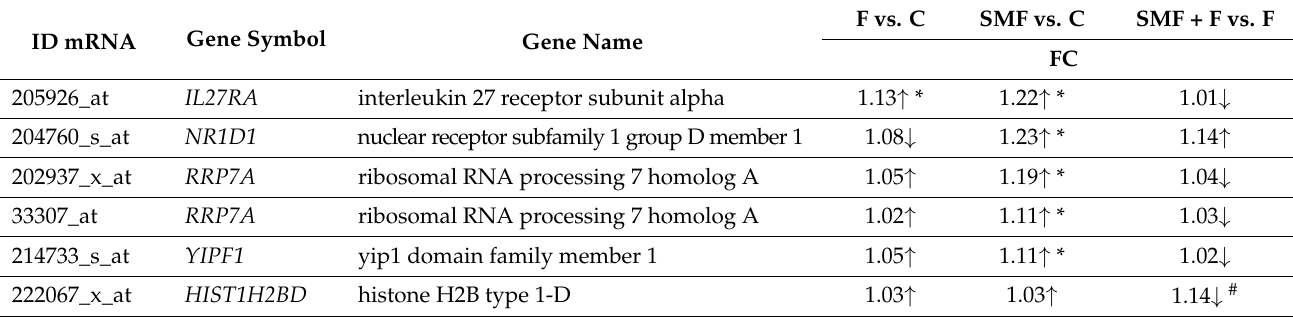
Table 1. List of differentially expressed genes determined by the oligonucleotide microarray technique.